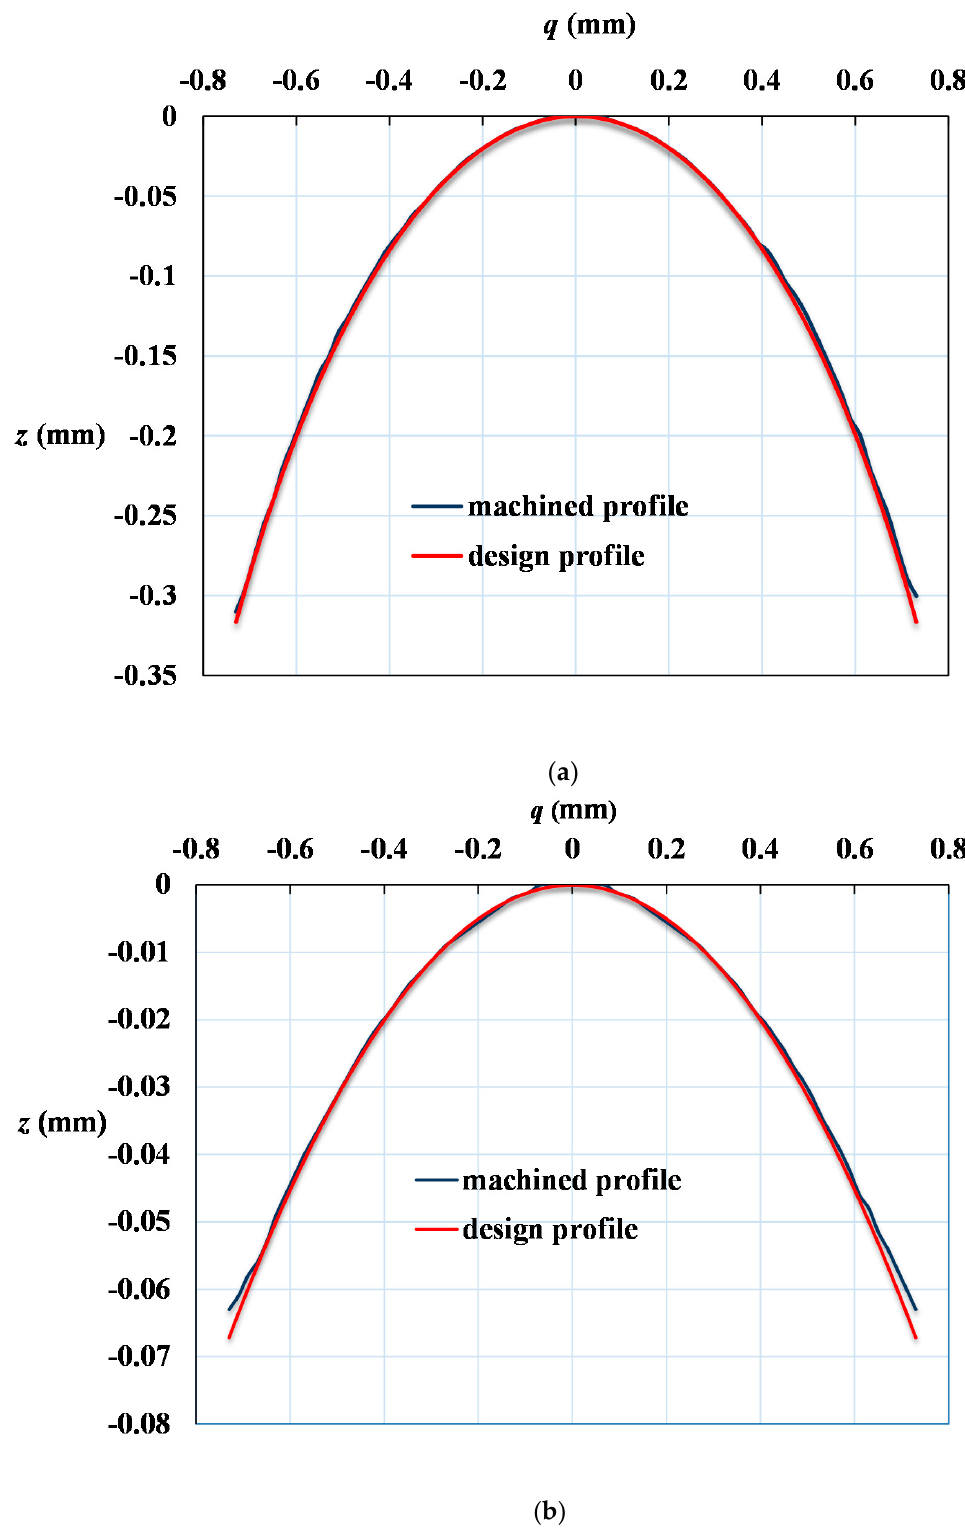
Figure 9. Comparison of machined curved surface profiles with theoretical conic section profiles calculated from Equation. ( a ) R = 1 mm. ( b ) R = 4 mm.